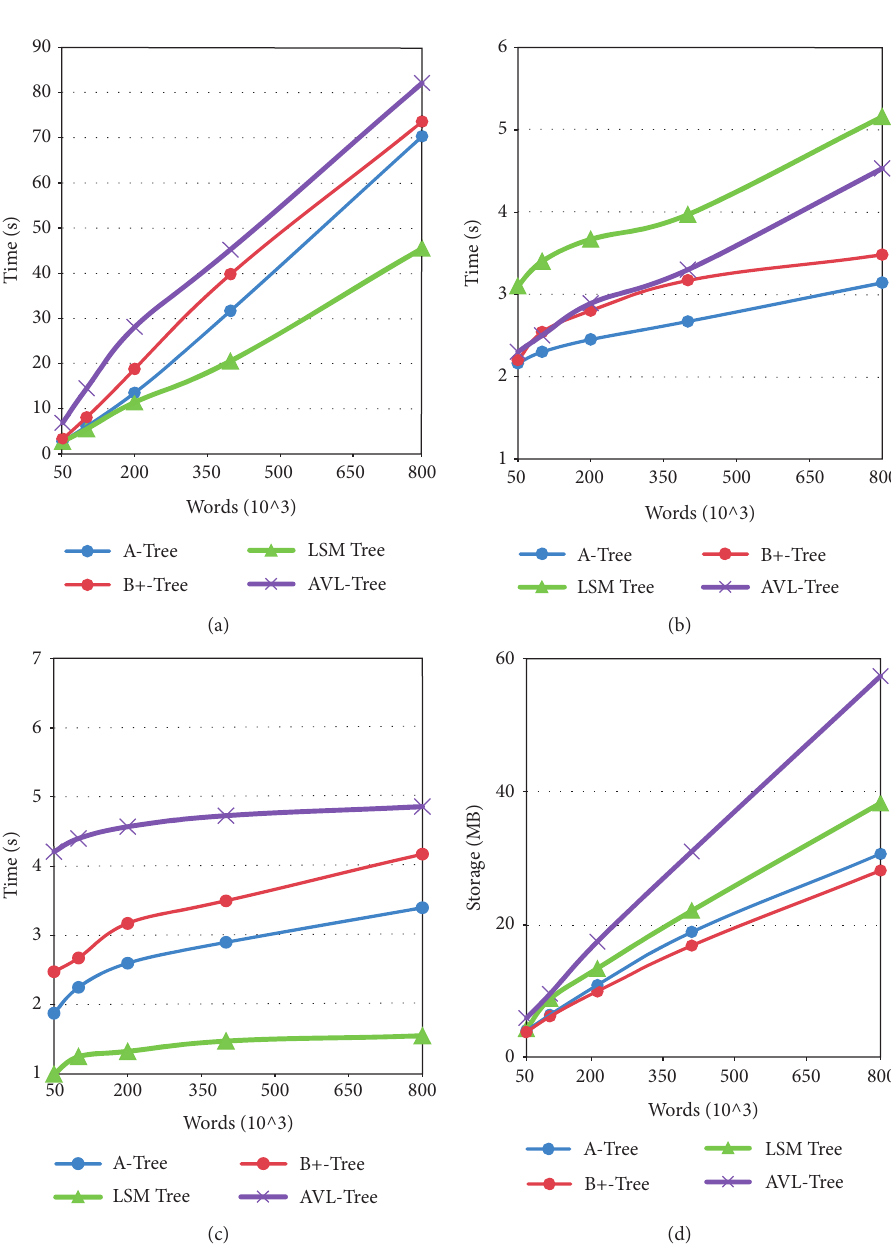
Figure 10: Experimental results of indexes